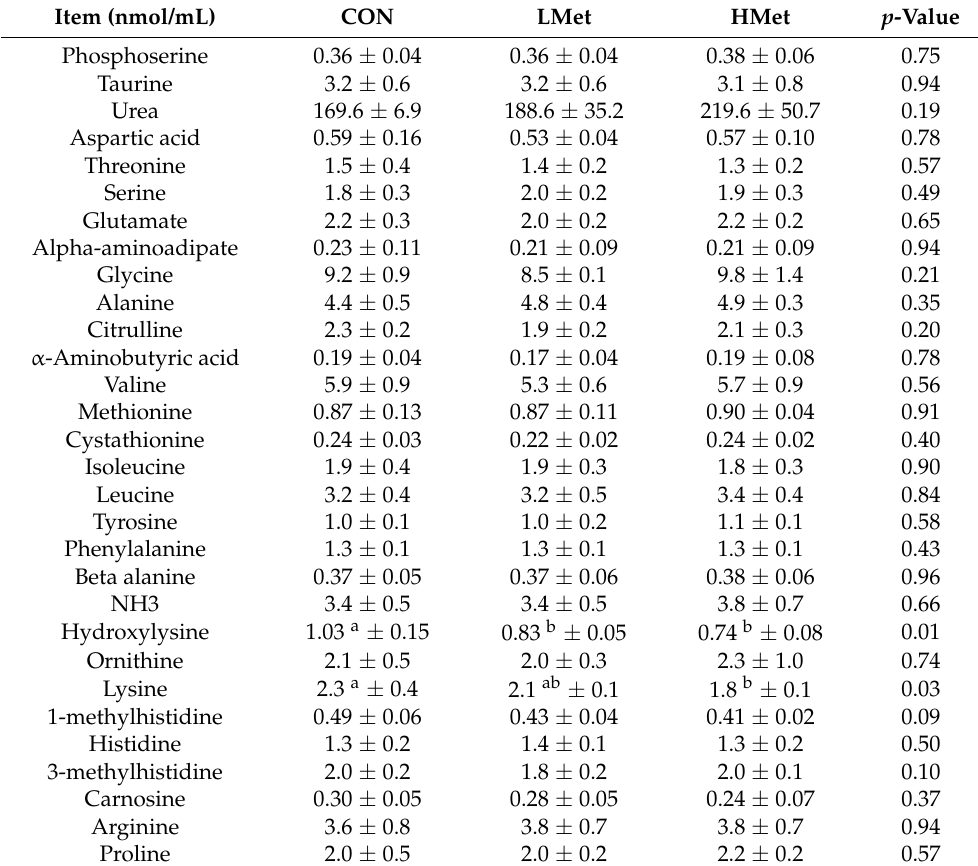
Table 5. Comparing the concentration of amino acids in the serum of sika deer among the three